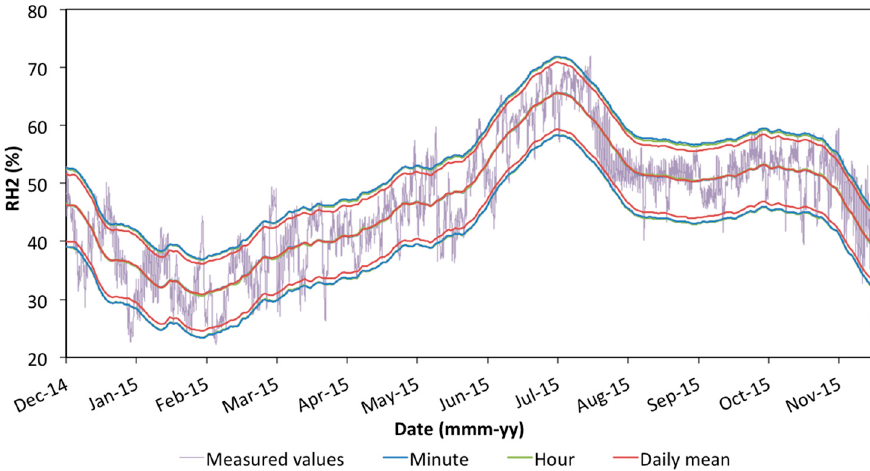
Figure 5. Seasonal RH cycles determined as the 30 days central moving average (MA) of RH data collected by Sensor 2 with different sampling methods. The lower and upper limit bands are calculated as the MA plus and minus the 7th and the 93rd percentiles of the short fluctuations, respectively. The grey line represents the RH values measured every minute from 1 December 2014 to 30 November 2015.